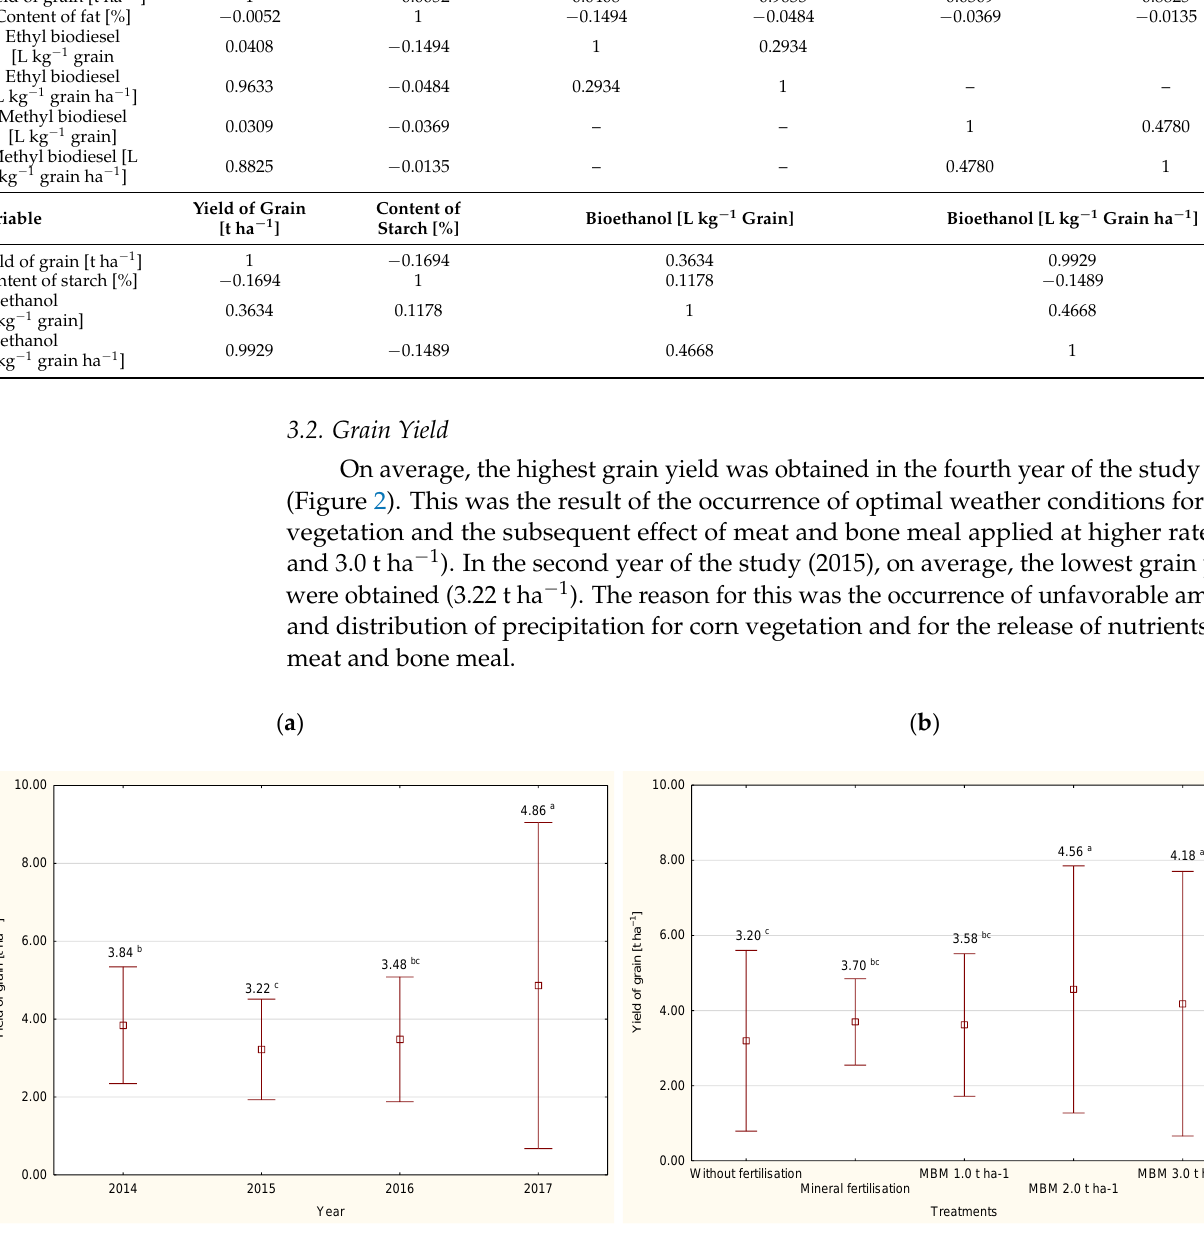
Figure 2. The corn grain yield (mean value and standard deviation), ( a ) average for the years, ( b ) average for the treatment. MBM — Meat and Bone Meal. a,b,c — Values followed by the same letters do not differ significantly in Tukey’s (HSD) test ( p < 0.05). Table 5. The corn grain yield, interaction between the years and treatments (mean value and stand- ard deviation), t ha – 1 .